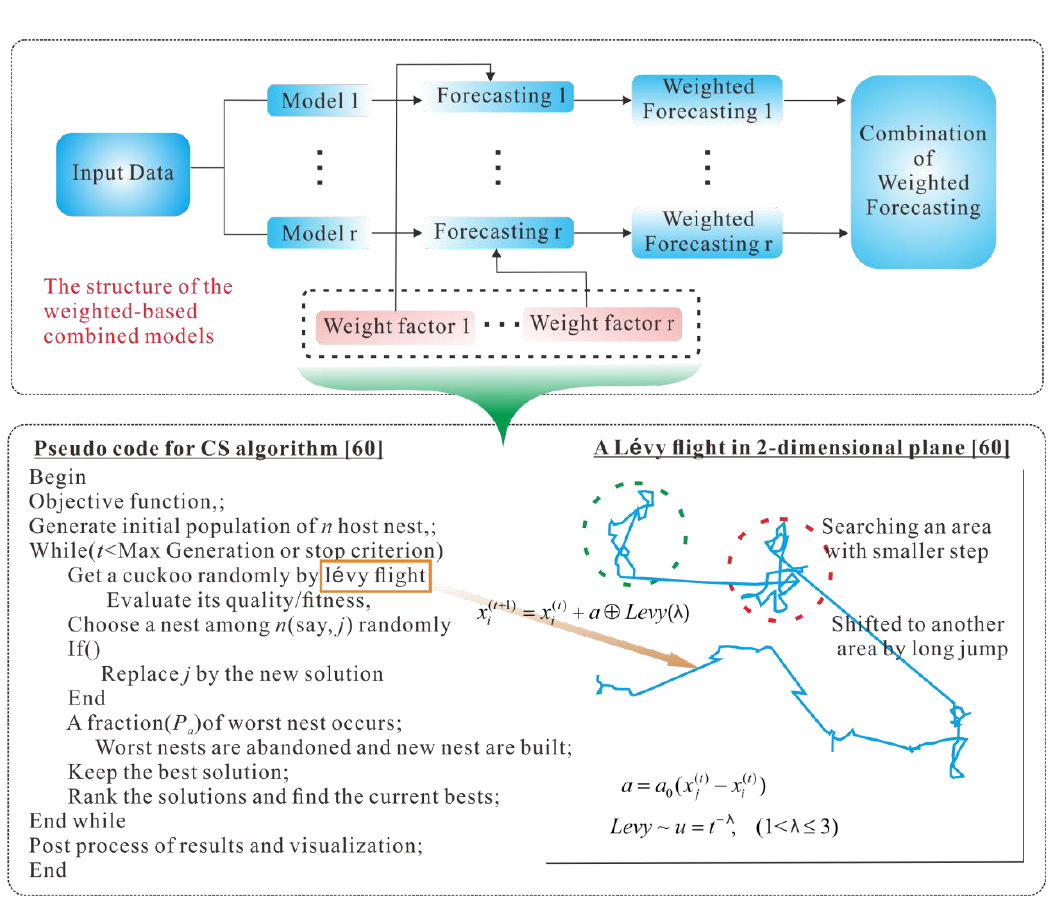
Table 2. Income classifications by gross national income (GNI) per capita according to the World Bank. Income Classifications